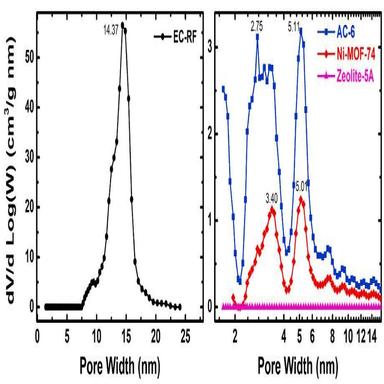
Pore size distribution from 2D-NLDFT model on N2 sorption isotherms at 77 K/1 bar assuming slit pore geometry for EC-RF (left) and other samples (right) as shown. The pore widths at peak maxima are also shown for quick comparison.